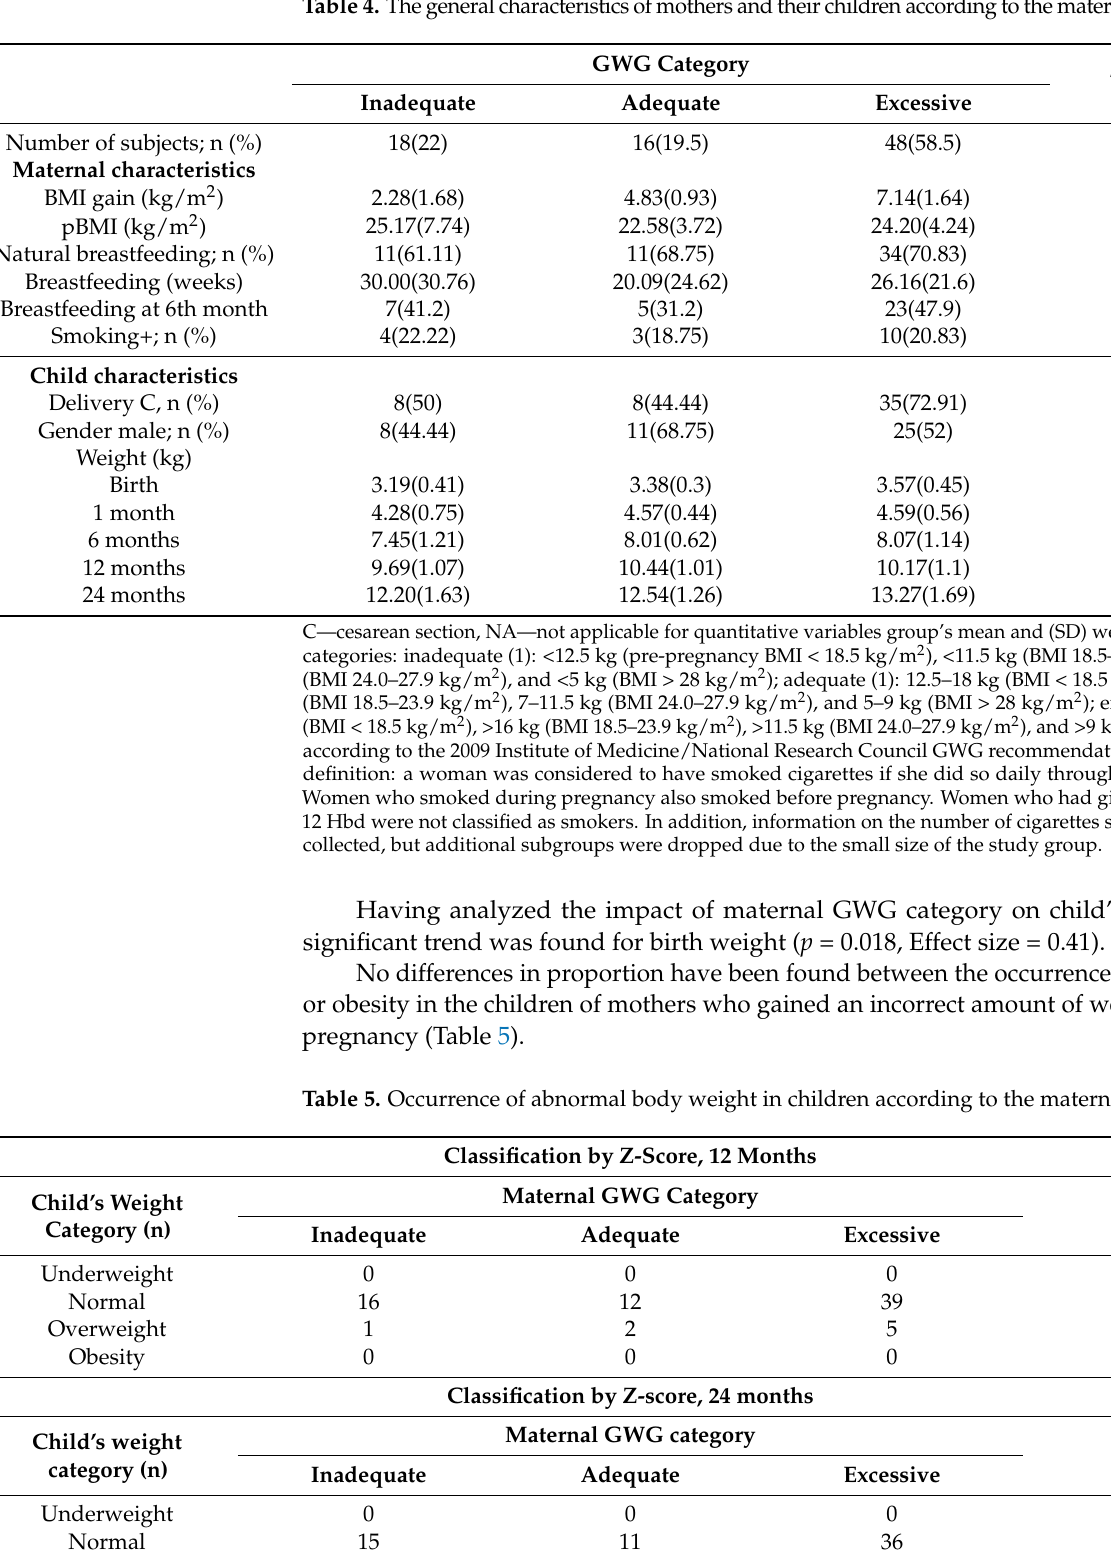
Table 4. The general characteristics of mothers and their children according to the maternal GWG category.